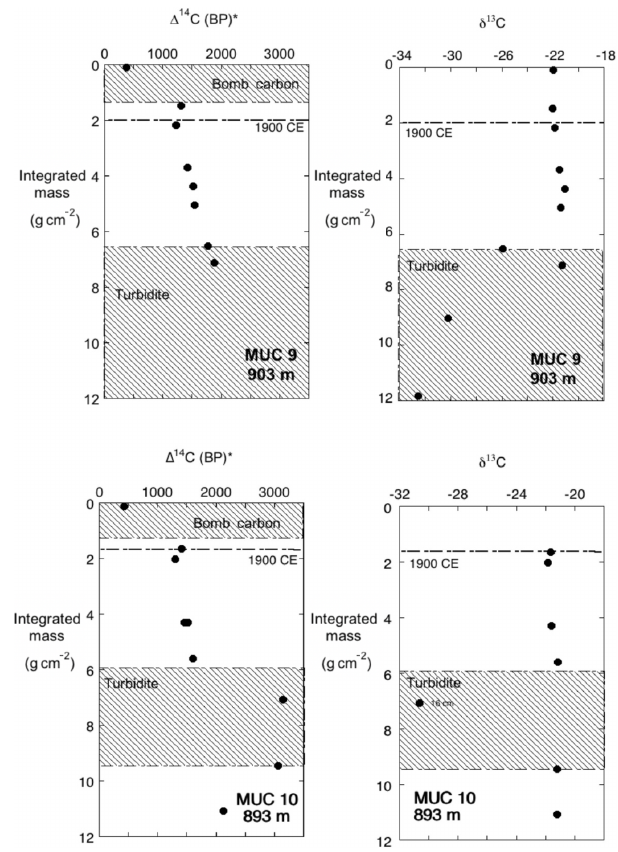
Figure 10. (cid:49) 14 C (BP) ∗ vs. integrated mass (gcm − 2 ), as in Fig. 9, including designation of turbidite and bomb carbon regions (hachured) and corresponding δ 13 C data. Dashed line at ∼ 2cm − 2 represents sediments deposited around